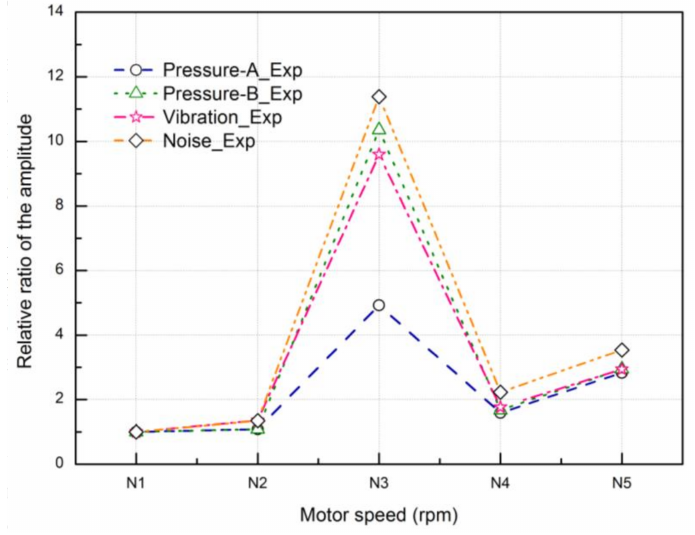
Figure 13. Comparison of the amplitudes corresponding to the primary frequencies for the Type A flapper-armature